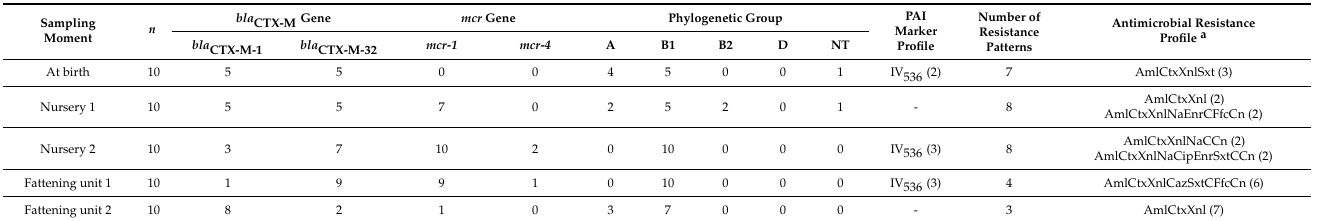
Table 1. Characteristics of bla CTX-M producing E. coli isolates recovered from piglets from a Portuguese farms over 5 sampling